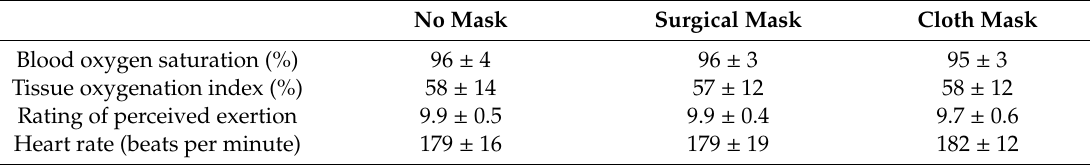
Table 1. Comparison between conditions at the end of the exercise